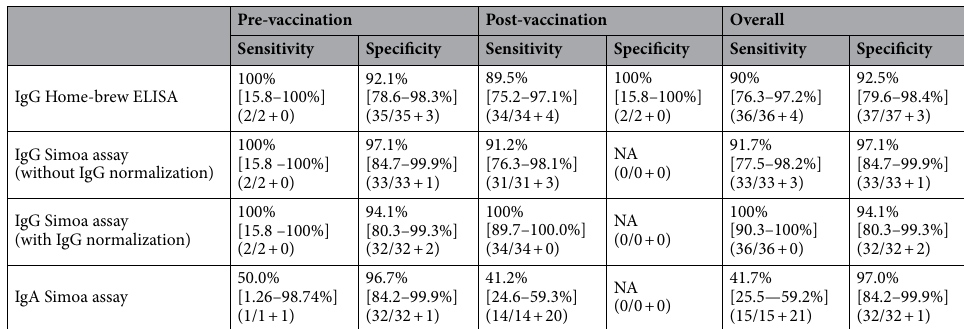
Table 1. Sensitivity and specificity diagnostic performance characteristics of the saliva-based IgG home- brew ELISA, IgG Simoa assay without IgG normalization, IgG Simoa assay with IgG normalization and IgA Simoa assay. Sensitivity = (True positives/True positives + False negatives). Specificity = (True negatives/True negatives + False positives). [95% confidence interval]. IgG Home‑brew assay: Two individuals had PCR- confirmed COVID-19 infection prior to vaccination. Both of these saliva samples tested positive in serum and saliva. All other participants (n = 38) were confirmed to be COVID-19 negative based on PCR testing. Antibody-positive saliva samples from individuals with antibody-negative serum were considered to be false- positive results. Saliva samples were concentrated prior to analysis. IgG Simoa assay without IgG normalization: The levels of SARS-CoV-2 RBD IgG were measured in paired serum and saliva samples from 36 pre-vaccinated individuals, serum from 35 post-vaccinated individuals, and saliva from 34 post-vaccinated individuals. Saliva samples were not concentrated prior to analysis. IgG Simoa assay with IgG normalization: The levels of SARS- CoV-2 RBD IgG were measured in paired serum and saliva samples from 36 pre-vaccinated individuals, serum from 35 post-vaccinated individuals, and saliva from 34 post-vaccinated individuals (paired serum and saliva samples were available from 33 individuals). Saliva samples were not concentrated prior to analysis. Saliva SARS-CoV-2 spike RBD protein IgG levels were normalized to total IgG levels. IgA Simoa assay: The levels of SARS-CoV-2 RBD IgA were measured in paired serum and saliva samples from 35 pre-vaccinated individuals, and 34 post-vaccinated individuals. Saliva samples were not concentrated prior to